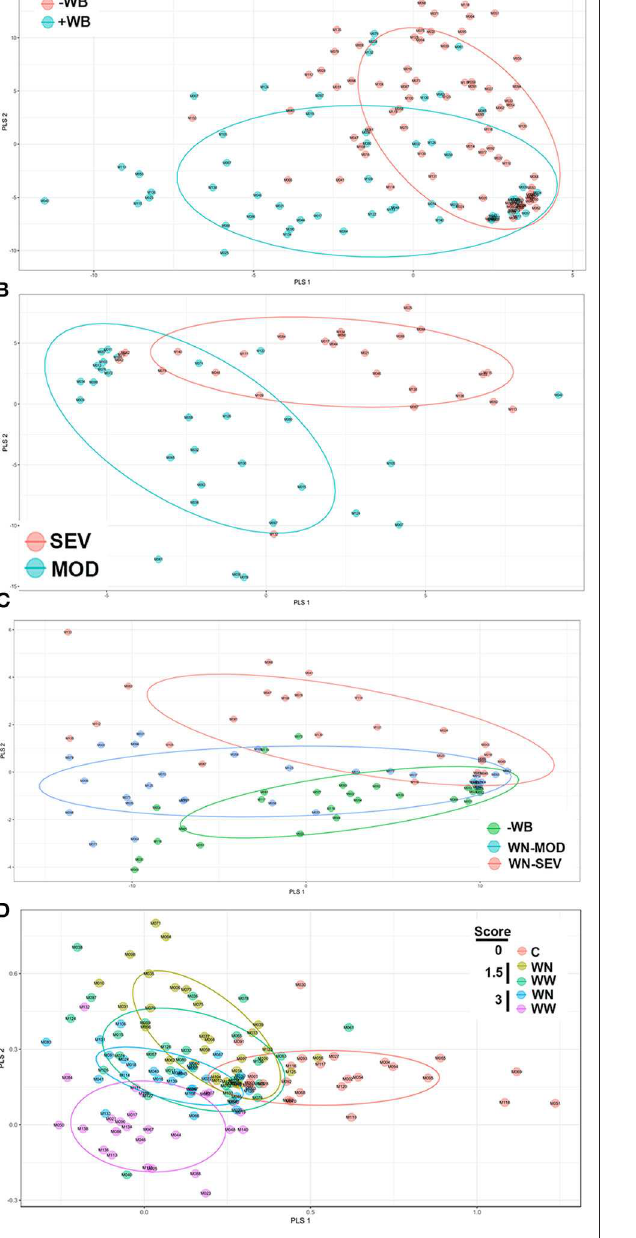
upstream analysis, and network discovery based on human metabolome database (29). Heat maps were made by Cluster 3.0 (30) and Javatreeview 1.1 (31) using log2 transformed data. P -values were calculated using Student’s T -test.